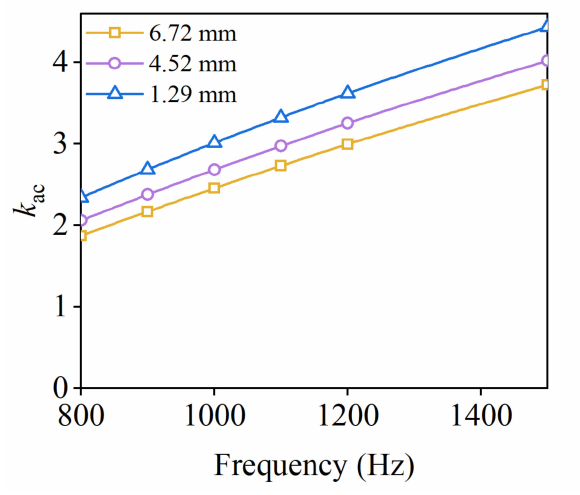
Figure 23. AC/DC copper loss ratio k ac with notch height at different frequencies.